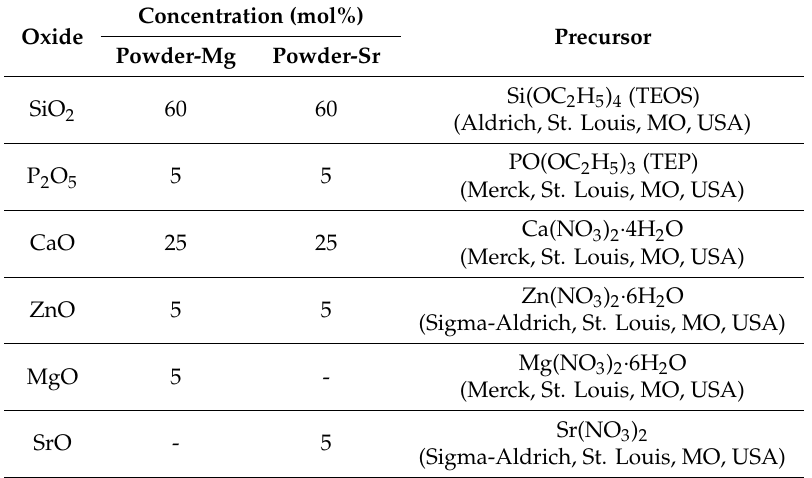
Table 1. Composition of the synthesized oxide powders and the corresponding reagents. Concentration (mol%) Oxide